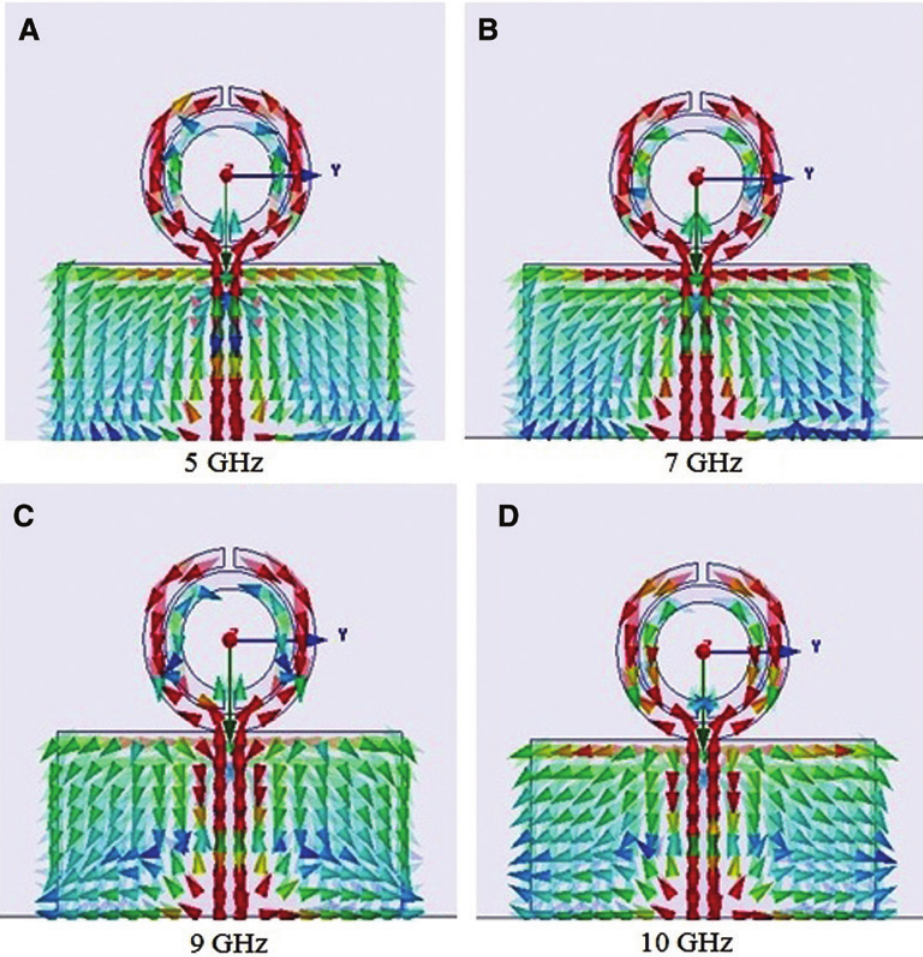
Figure 4: Surface current distribution of the proposed antenna at (A) 5GHz, (B) 7GHz, (C) 9GHz, and (D) 10 GHz.